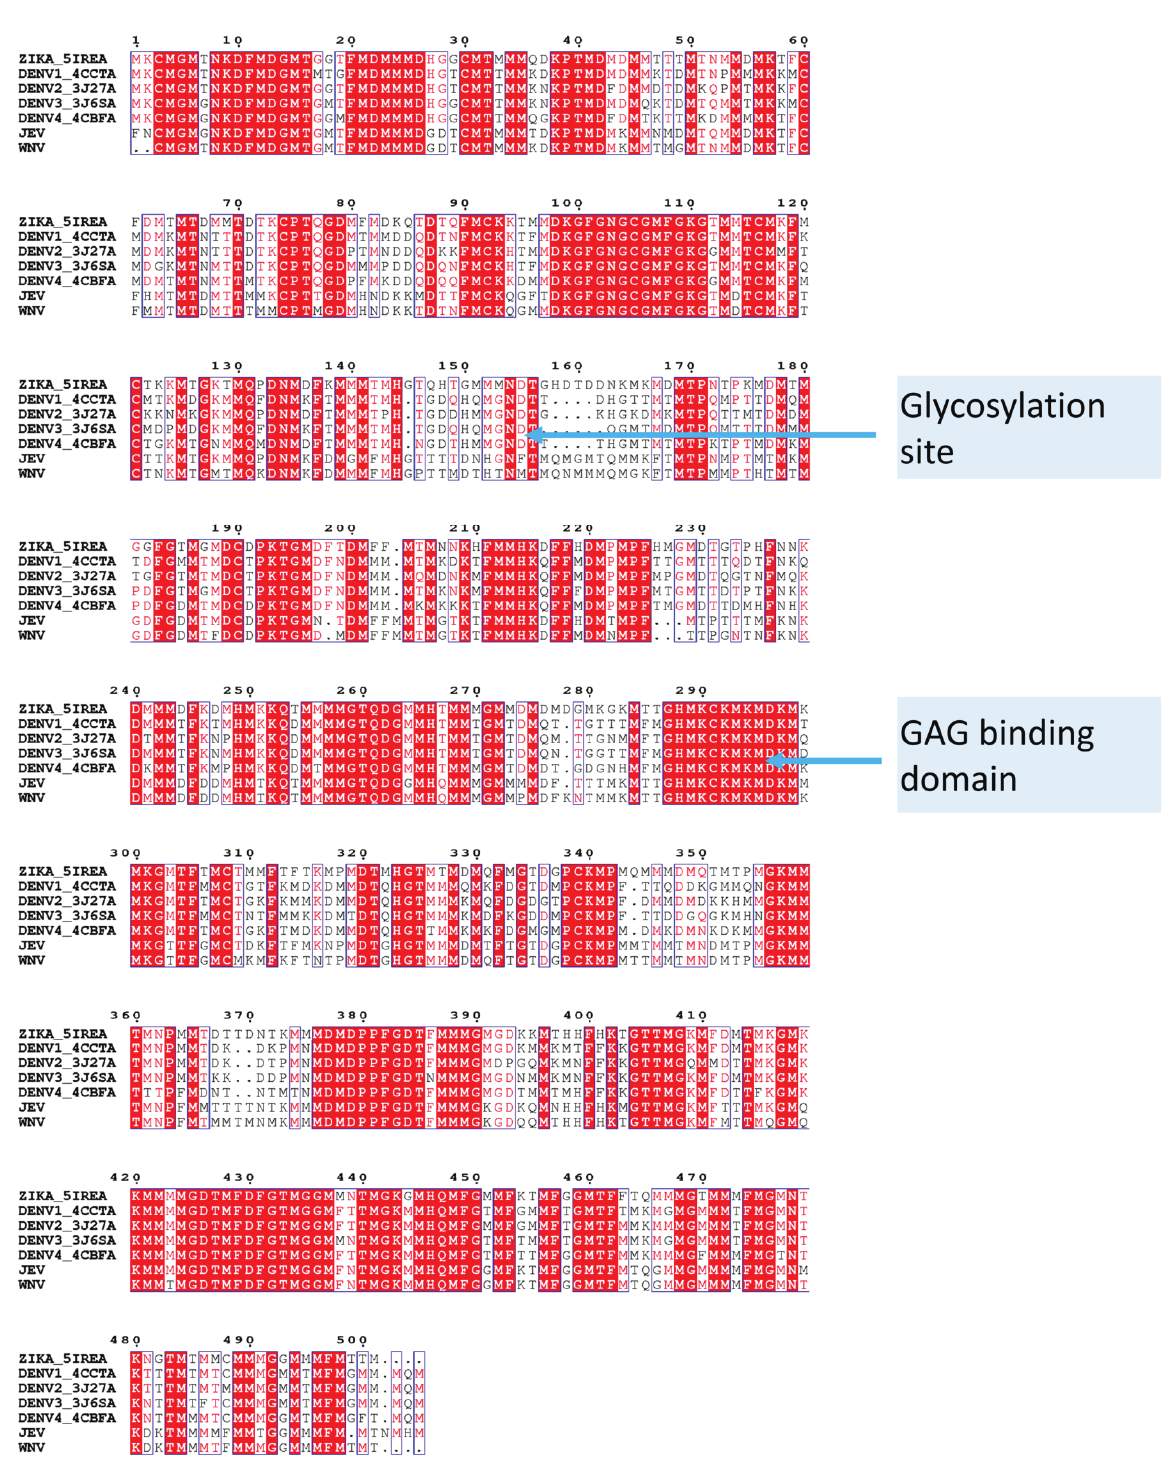
Figure 3. Multiple sequence alignment (MSA) of envelope (E) proteins from ZIKA/DENV1-4/JEV/WNV after substituting for stereochemical equivalence. The following substitutions were done in the sequence space: E>D, R>K, S>T, W>F, Y>F, L>M, V>M, I>M, A>M in order to use a single amino acid for positive, negative, aromatic and non-polar residues. Gly (without a side chain) and Pro (with a cyclic side chain) were not substituted. His was also not substituted, due to its importance in pH sensing among flaviviruses 9,10 . These substitutions enable MAFFT to align the glycosylation site properly. Also, these show the stereochemical equivalence of the cationic residues β -21 in ZIKV (PDB ID:5IREA), which is part of the GAG-binding